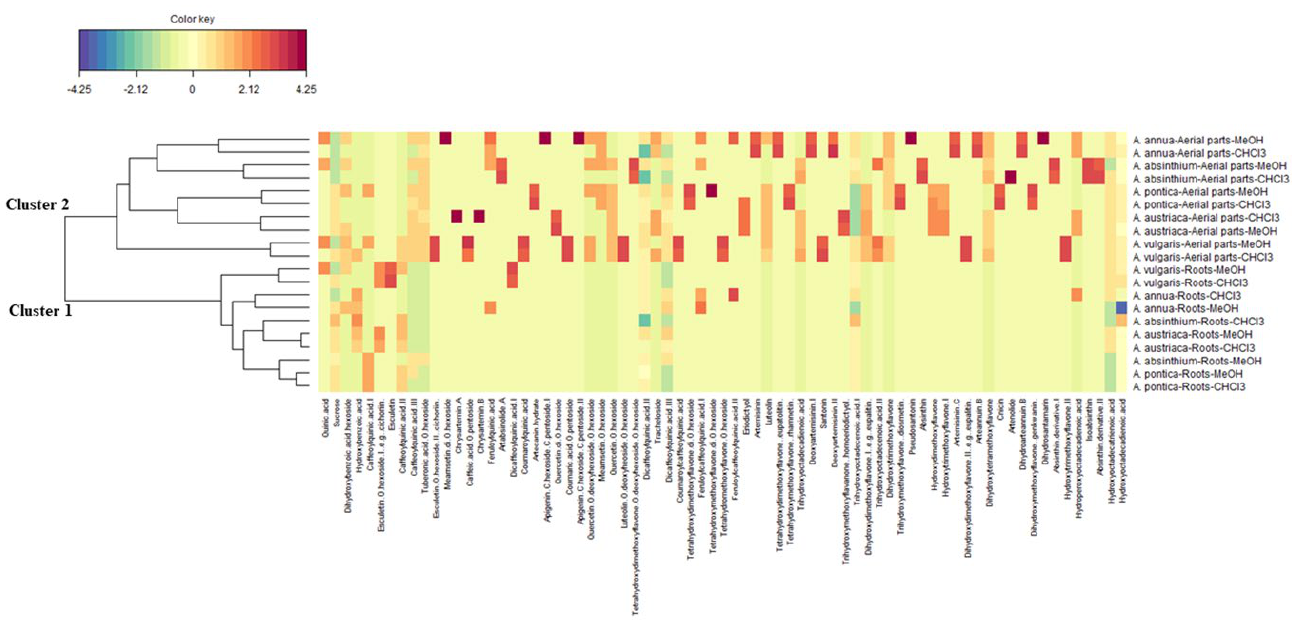
Figure 4. Clustered image map (red color: high bioactivity; blue color: low bioactivity) based on the chemical composition dataset.